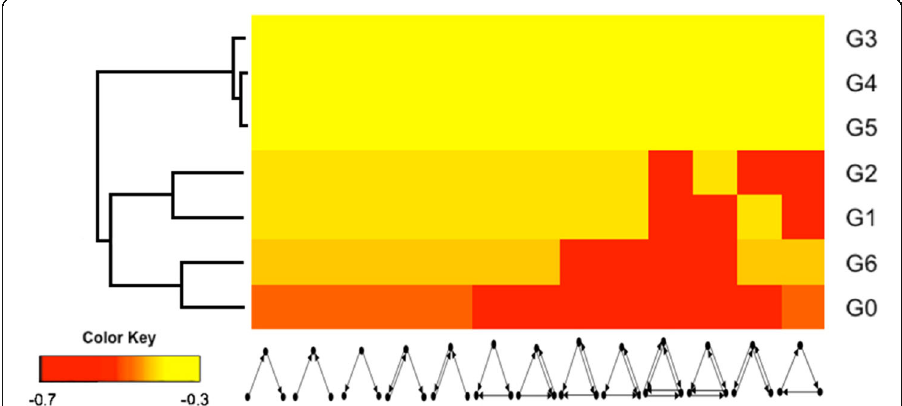
Fig. 4 Heatmap of normalized Z-scores of different triadic motif types in different mobility